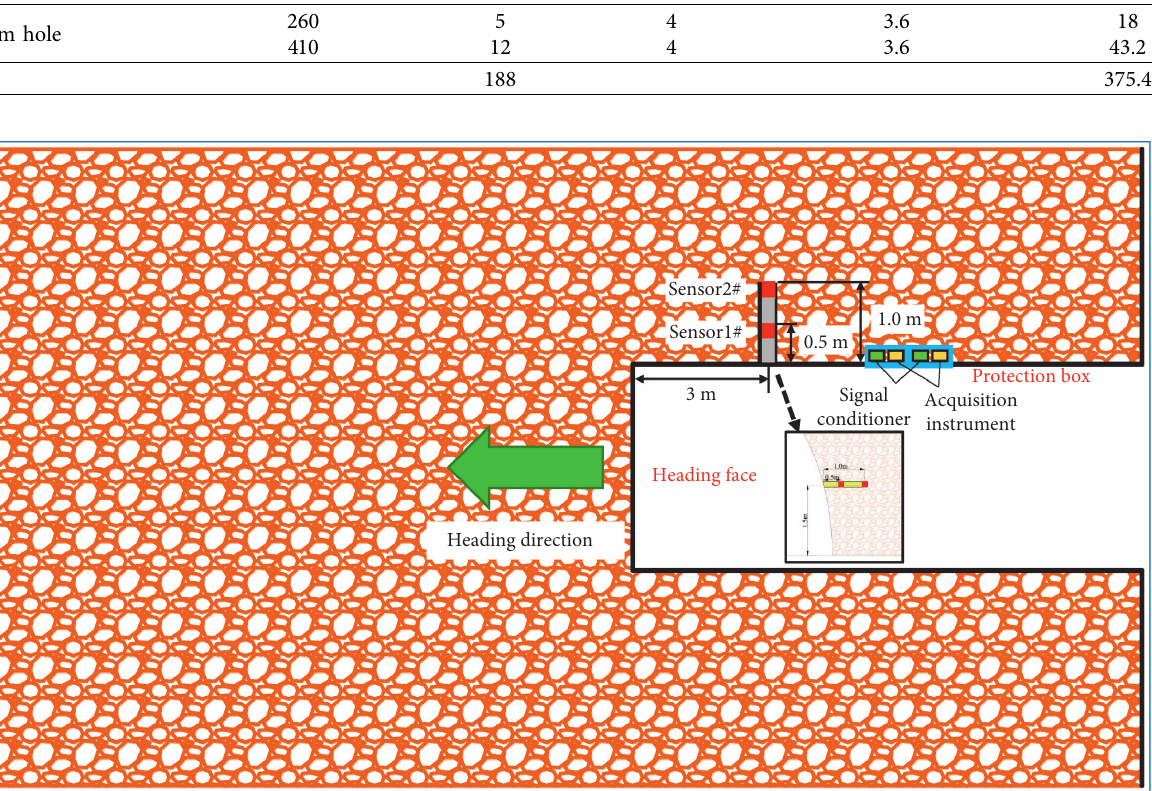
Figure 3: Blasting vibration monitoring scheme.